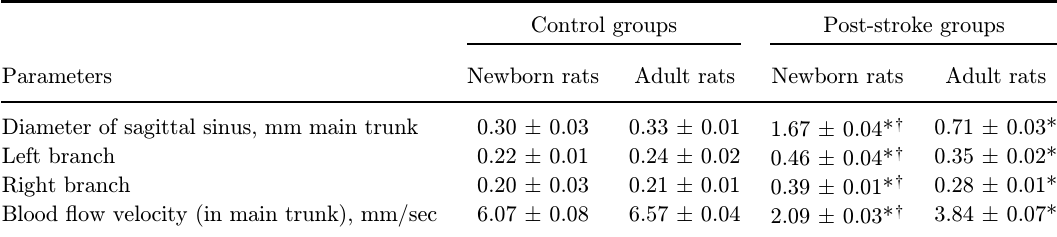
Table 2. The hemodynamic parameters of the sagittal sinus in newborn and adult rats in the control and the post-stroke groups.